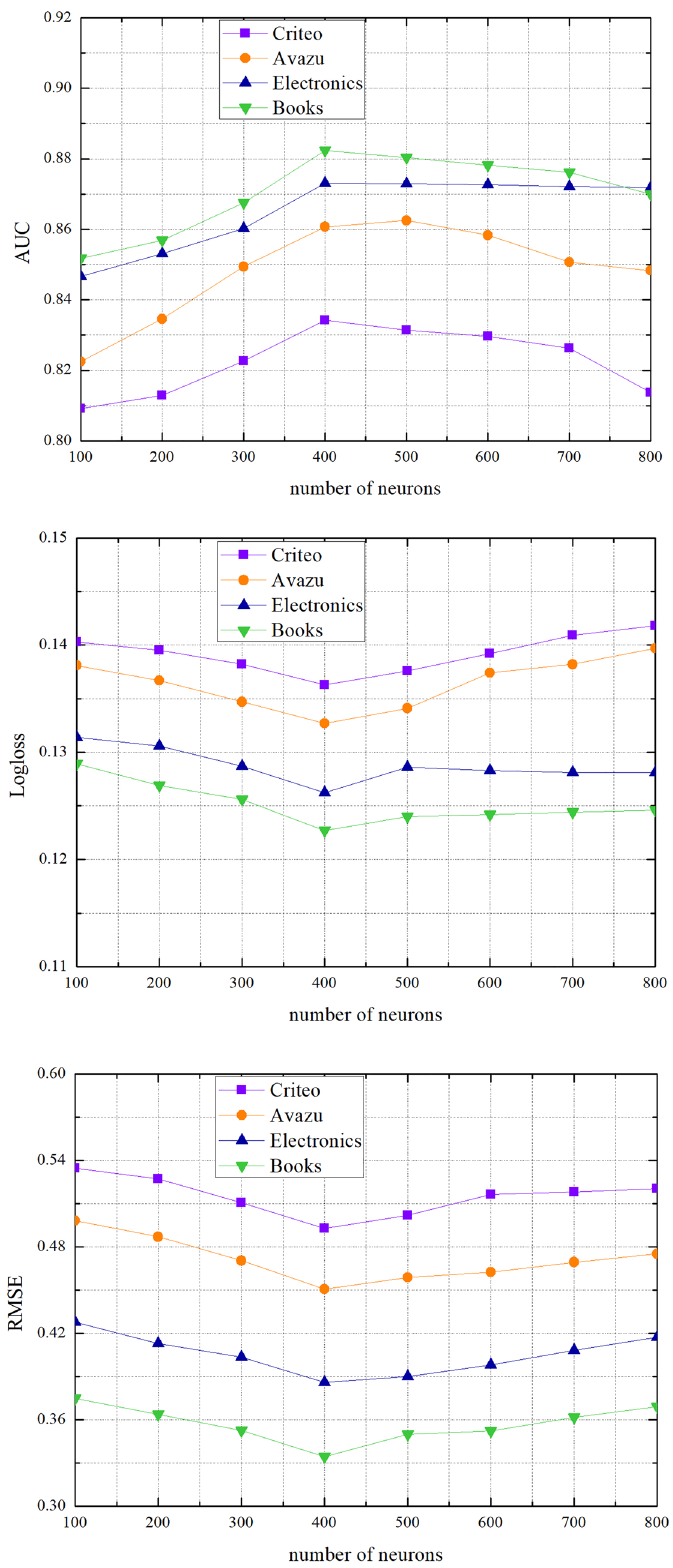
Figure 5. Performance comparisons w.r.t. the number of